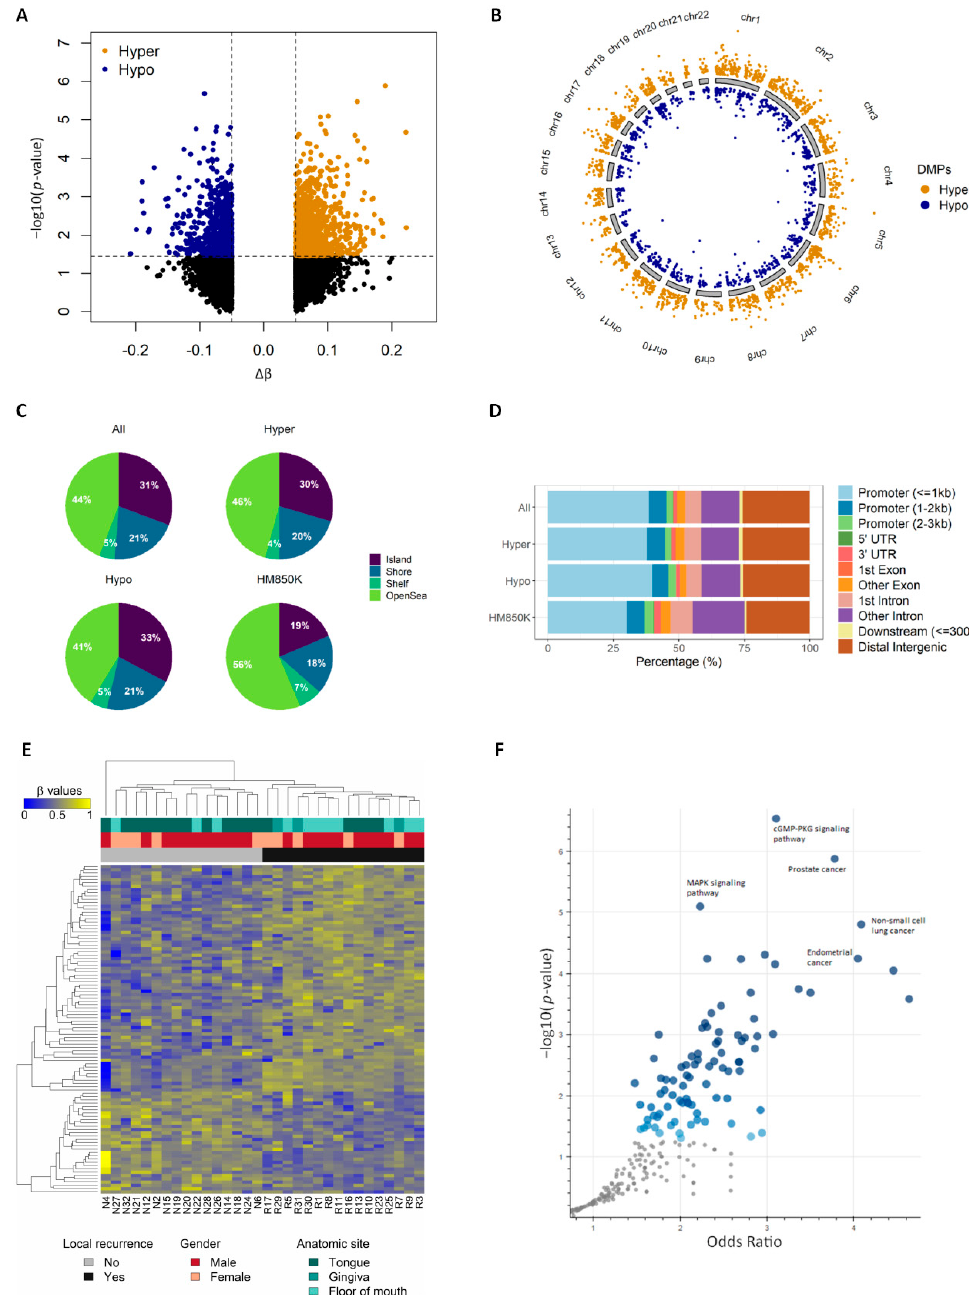
Figure 2. Identifying tumor-specific DMPs (5% ∆ β ) across the genome. ( A ) volcano plot showing hyper and hypo methylated CpGs between recurrent and non-recurrent cases. The x -axis representing the differential methylation between the groups is plotted against the statistical significance of each probe analyzed. Hypermethylated probes with adjusted p -value > 0.1 and ∆ β ≥ 0.5 are represented in orange, while hypomethylated probes with adjusted p -value > 0.1 and ∆ β ≤ − 0.5 are represented in blue; ( B ) genome-wide DNA methylation profile of patients that developed local recurrence, by chromosome. Orange dots represent hypermethylated probes, blue dots represent hypomethylated probes; ( C ) CpG context of the identified DMPs in CpG islands, shores, shelves, and open sea. All ( n = 2512), hypermethylated ( n = 1594) and hypomethylated ( n = 918) DMPs are compared with the HM850K array ( n ∼ = 85,000); ( D ) genomic annotations of the identified DMPs in the human genome. Plot generated using ChIPseeker package; ( E ) heatmap showing the top 100 DMPs associated